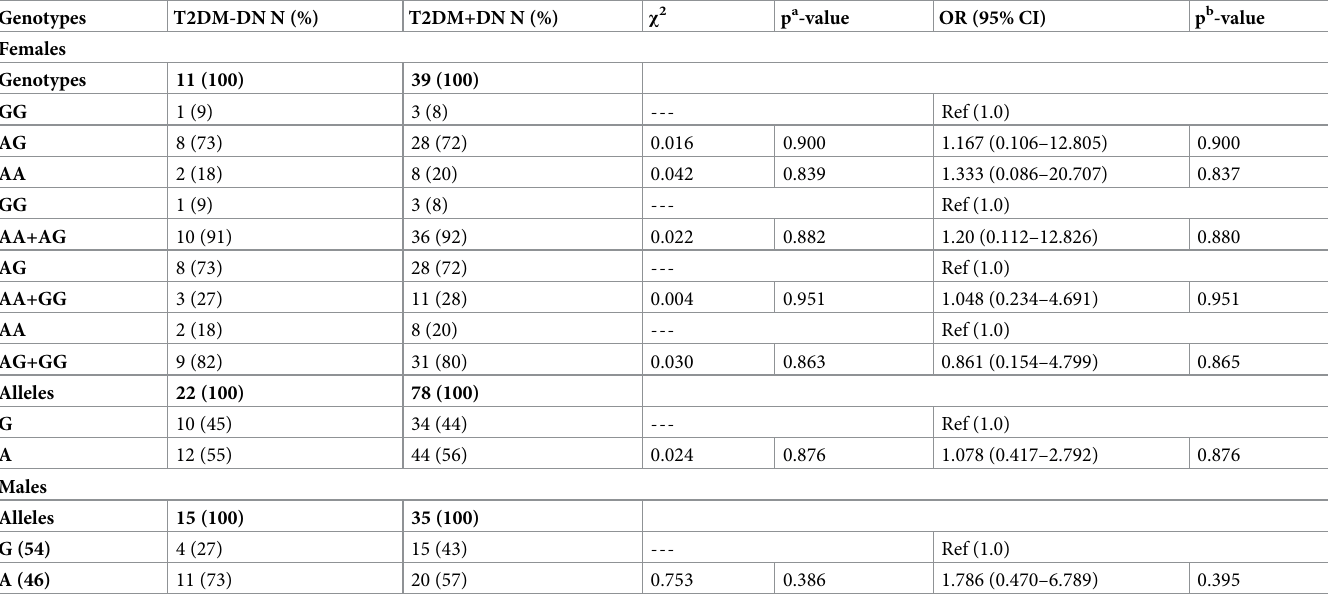
N = number of individuals. % Frequency is shown in parentheses. T2DM+DN: Type 2 diabetes with diabetic nephropathy, T2DM-DN: Type 2 diabetes without diabetic nephropathy. Differences in the frequencies of the genotypes between diabetic patients with or without diabetic nephropathy were compared using Chi-square ( X 2 ) test and without adjusting for other covariates. Odds ratios with 95% confidence interval (95% CI) are presented and adjusted with other covariates. p a - value (chi-square p- value); p b -value (Odd ratio